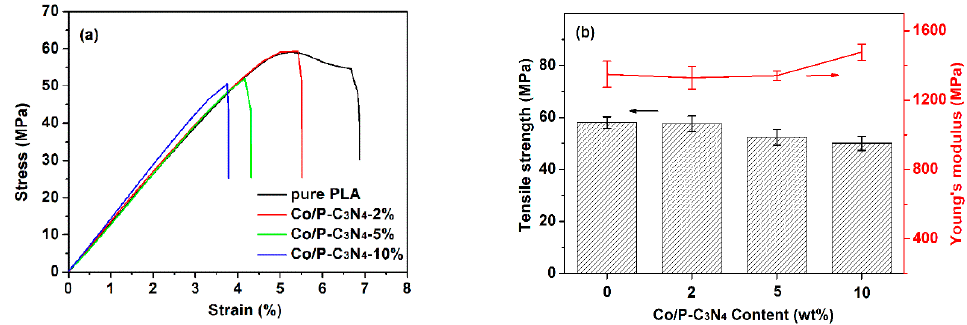
Figure 11. ( a ) Typical stress-strain curves, ( b ) tensile properties of pure PLA and PLA composites.